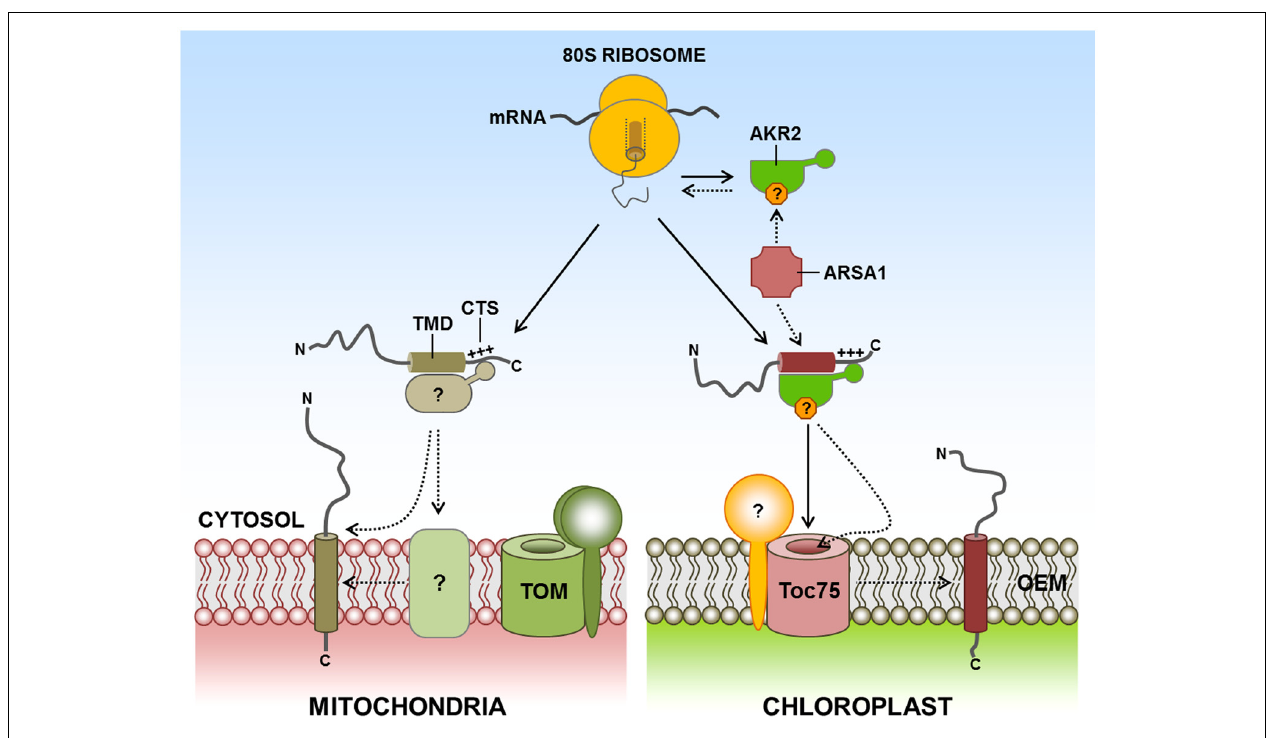
FIGURE 3 |Targeting of TA proteins to the chloroplast and mitochondrial outer membranes. TA proteins are characterized by a C-terminal single TMD and the CTS. However, little information is available about the molecular machinery and mechanisms of the targeting of TA proteins to the outer membranes of chloroplasts and mitochondria. AKR2 also binds to chloroplast outer membrane TA proteins such as OEP9, Toc33, and Toc34. In addition, the cytosolic factor ARSA1 mediates the biogenesis and targeting of Toc34 from the cytosol to the chloroplast